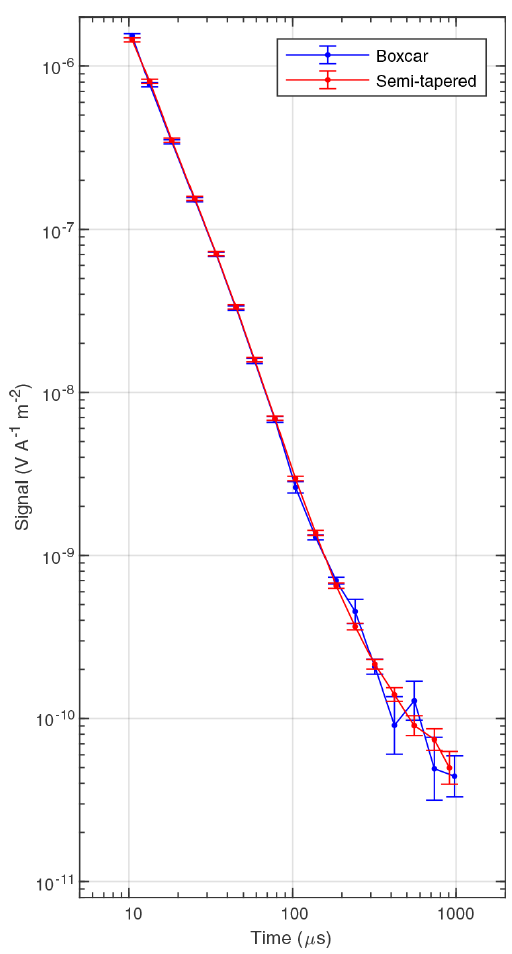
Figure 4. Sounding curves, boxcar and semi-tapered, from the Gedved survey. Each sounding curve contains 17 gates. The boxcar and semi-tapered gates are constructed from the sub-gates shown in Fig.